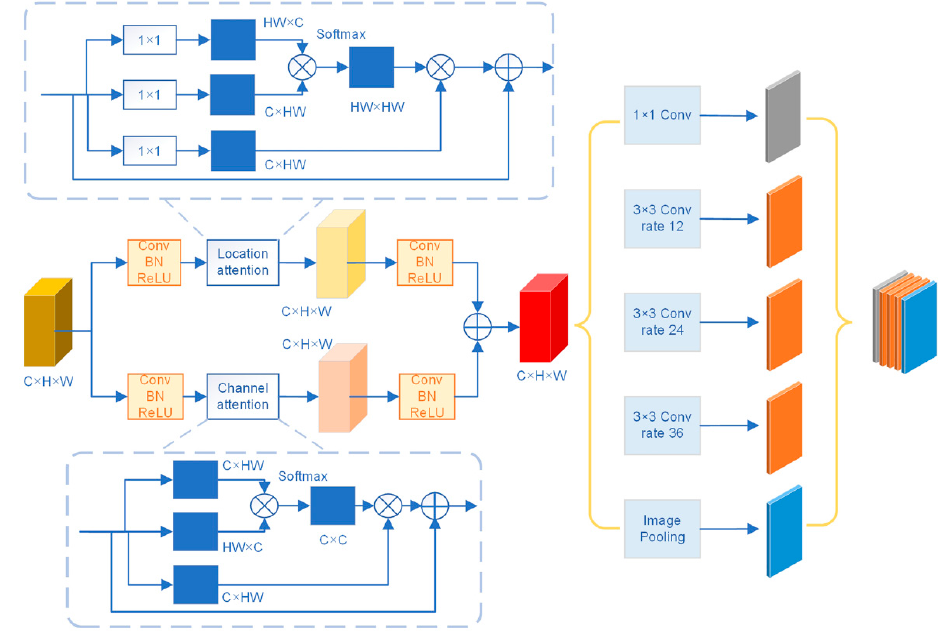
Figure 3. Multi-scale attention mechanism module.